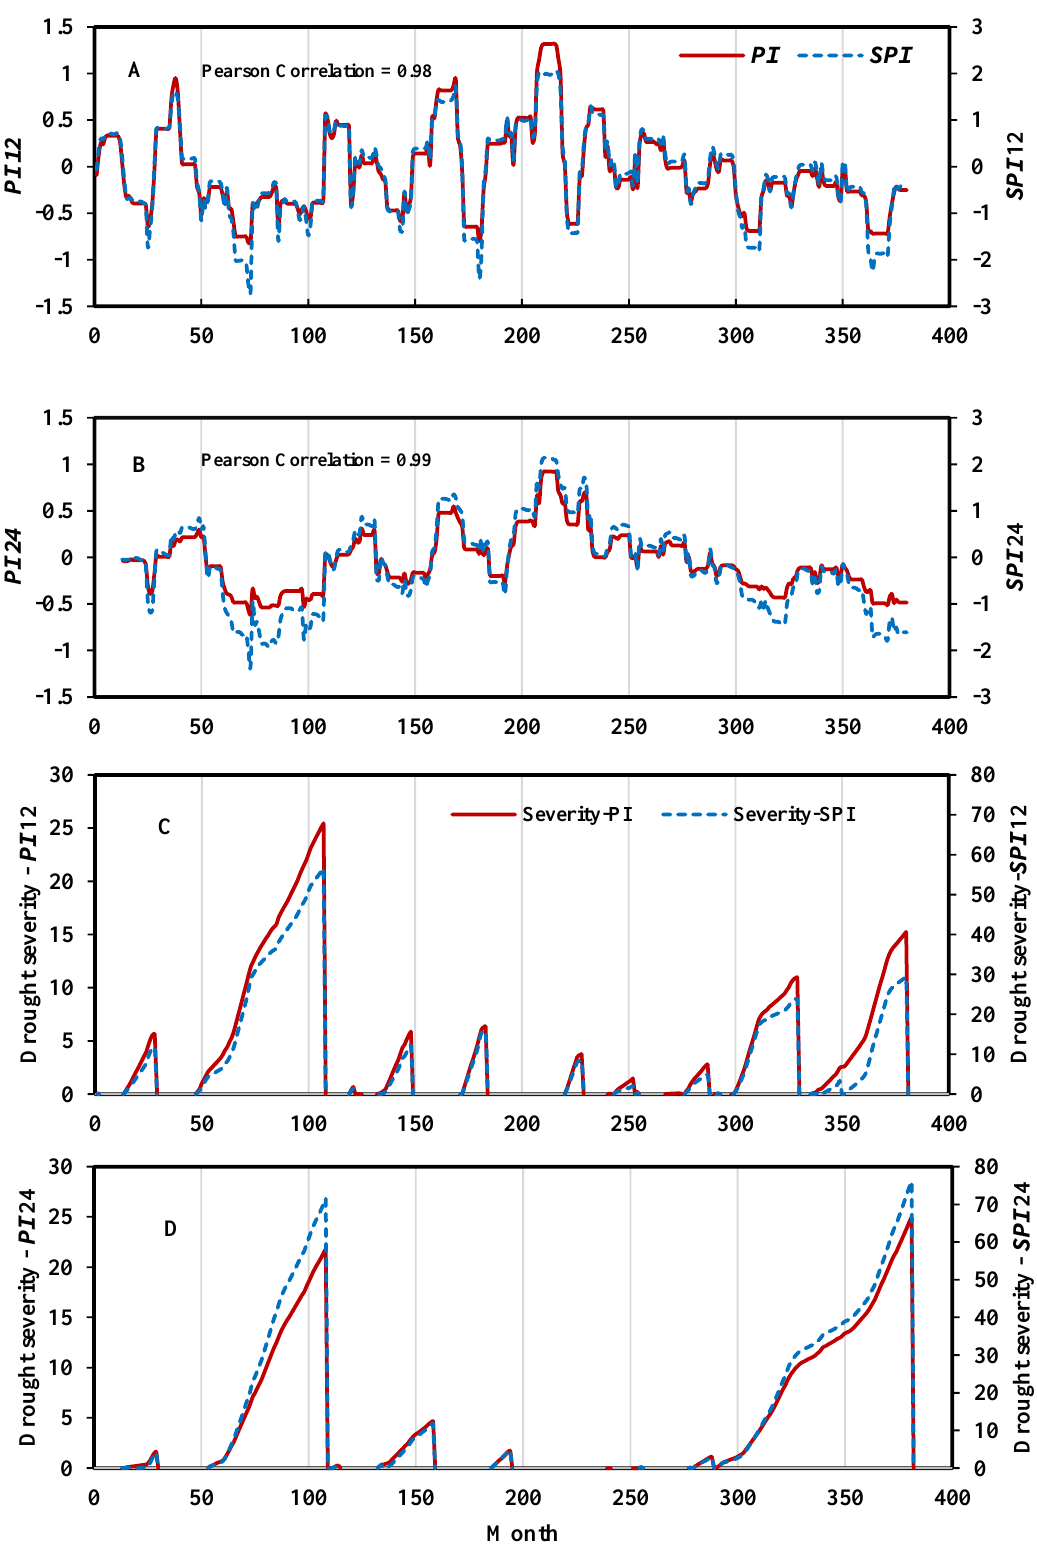
Figure 4. SPI and PI time series comparison at ( A ) 12-month time scale and ( B ) 24-month timescale. In addition, drought severities as calculated by SPI and PI methods are compared at ( C ) 12-month time scale and ( D ) 24-mont time scale. Comparisons were performed using precipitation data from December 1958 (month 1) until July 1990 (month 380) collected from Kuwait International Airport (KIA)